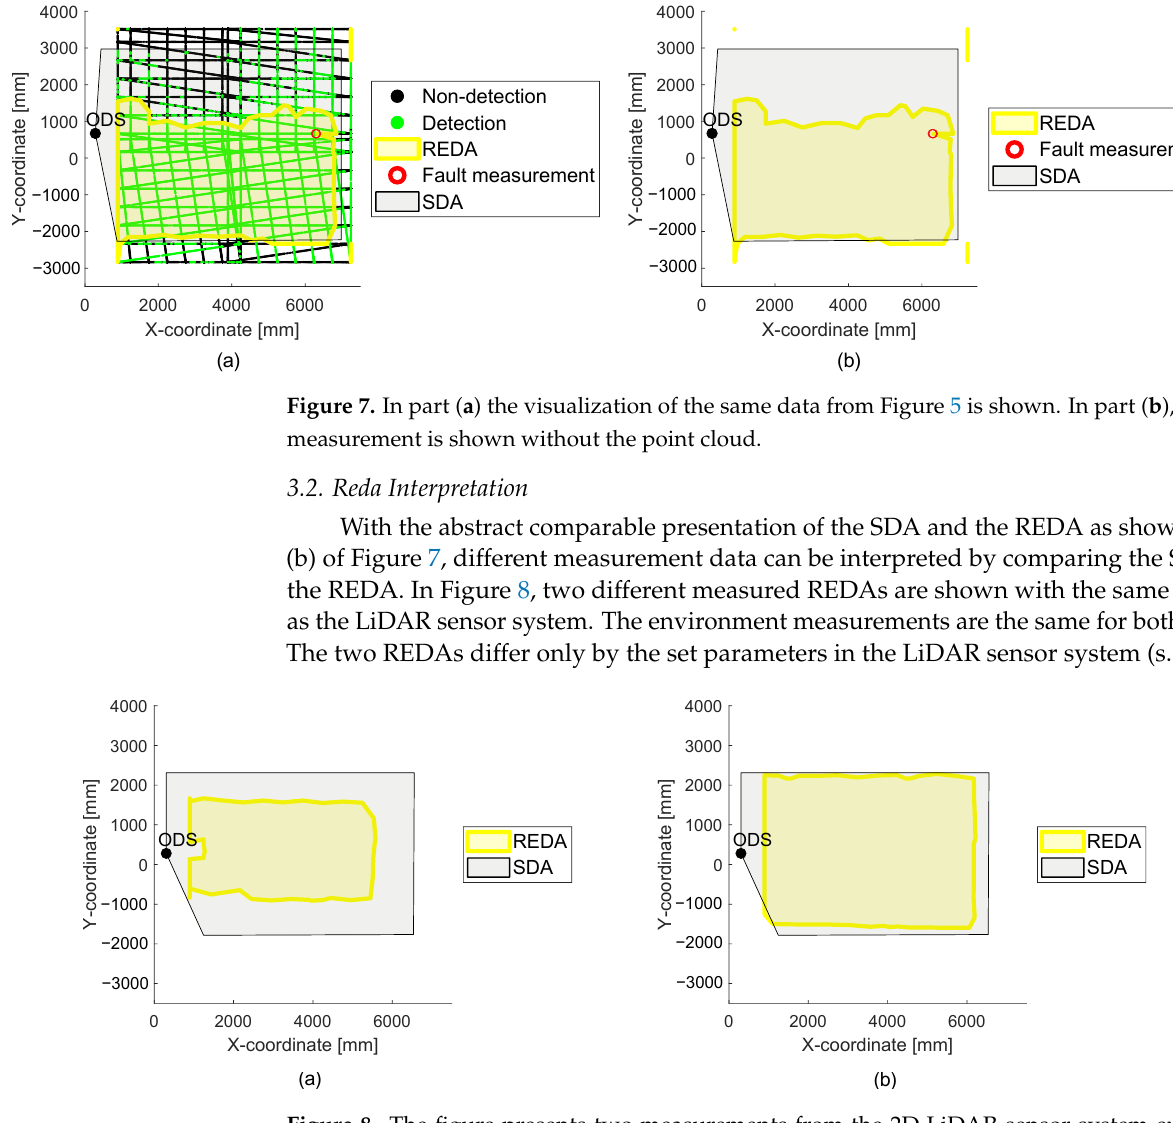
Figure 8. The figure presents two measurements from the 2D LiDAR sensor system example of this article. In part ( a ), a REDA of the ODS with a set reaction time of 320 ms is shown compared to a REDA of the ODS with a set reaction time of 80 ms shown in part ( b ). There are the same environmental conditions during the two